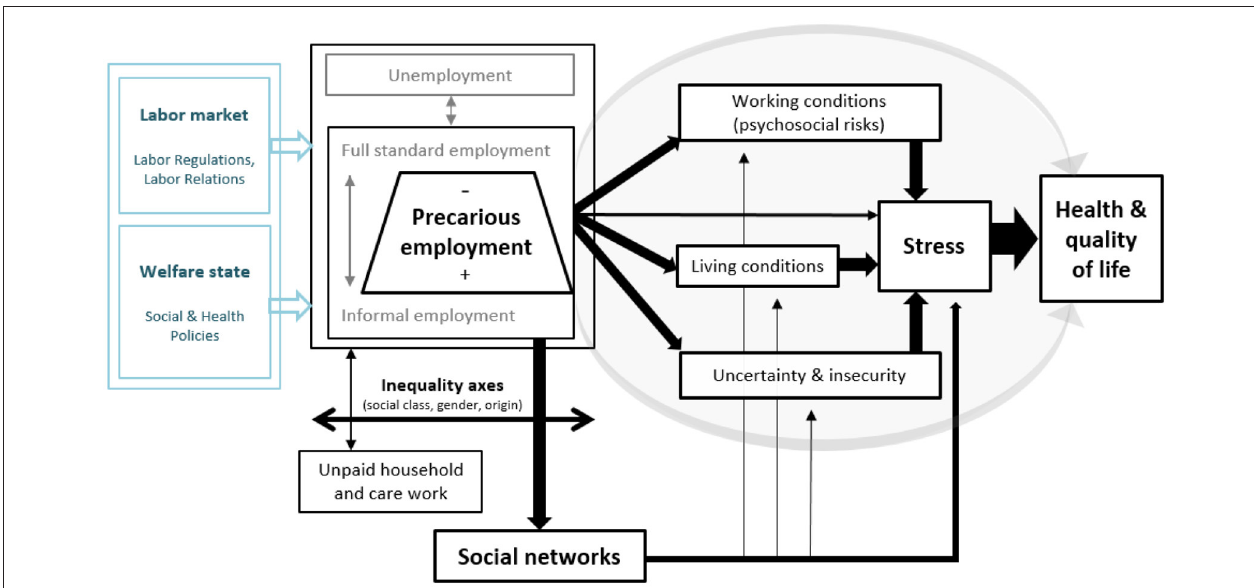
FIGURE 1 | Conceptual framework of precarious employment and the pathways through which it has an impact on stress and health (in black, the core elements addressed empirically in the PRESSED project). Source: Authors’ own based on the models of Benach et al. ( 60) and Julià et al.